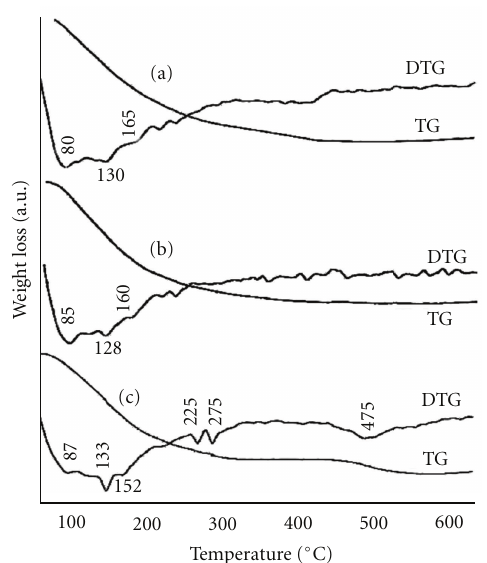
Figure 4: Thermal analysis curves spectra of (a) the NCY, (b) Fe- NCY, and (c) Fe-OP-NCY